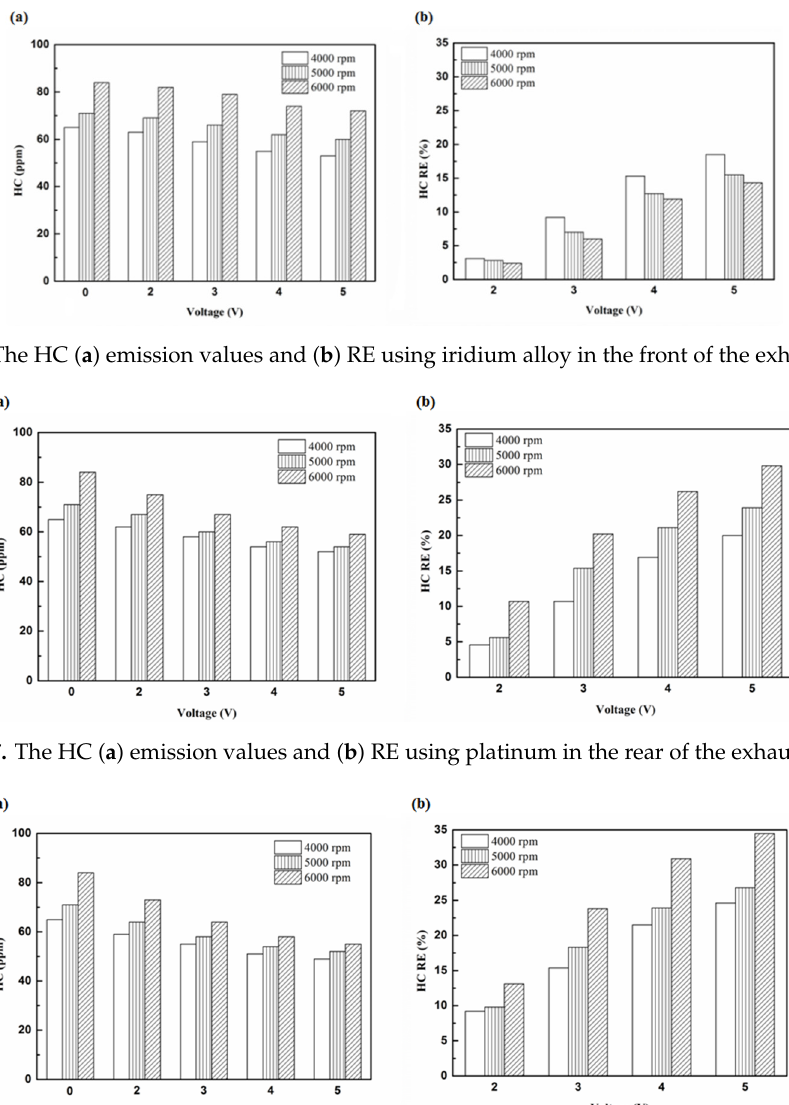
Figure 8. The HC ( a ) emission values and ( b ) RE using iridium alloy in the rear of the exhaust pipe.